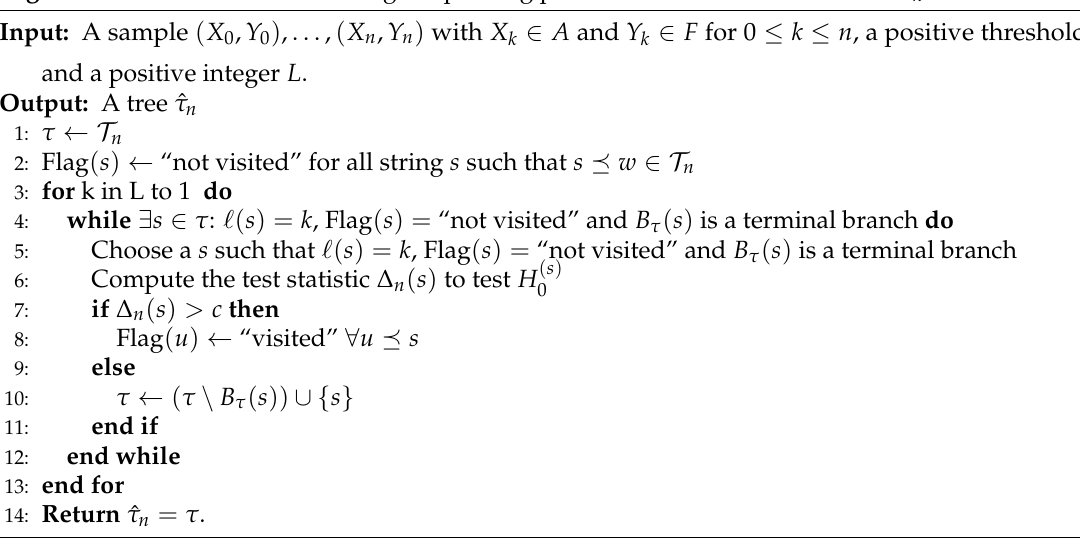
Algorithm 1 Pseudocode describing the pruning procedure used to select the tree ˆ τ n